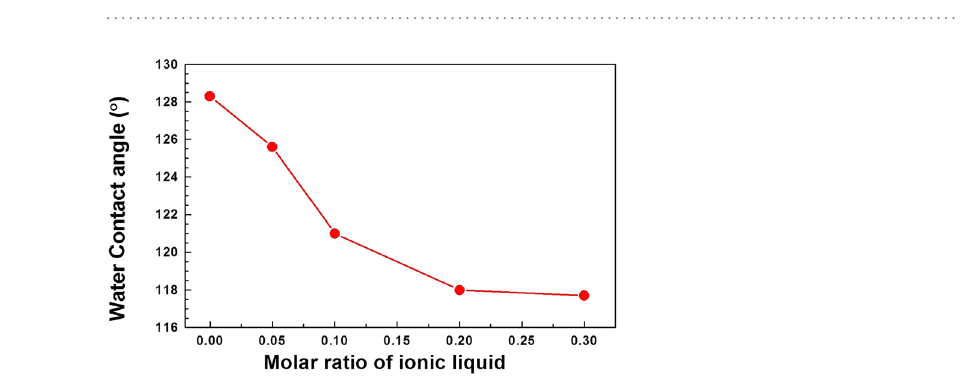
Figure 5. ( a ) Reversible wettability of the membrane PPHM-3 for water droplets. The membrane was repeatedly treated by ethanol and dried in vacuum oven at 80 °C for 12 h. ( b ) The separation efficiency of PPHM-3 at different cycles.